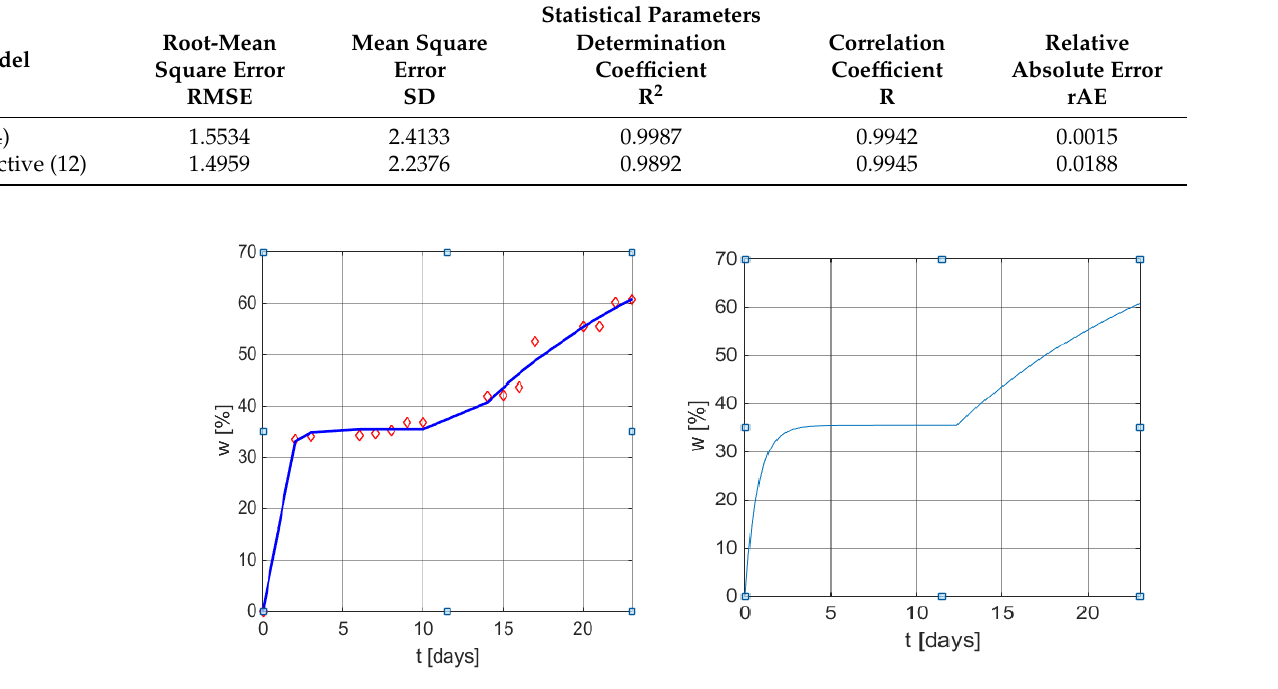
Table 3. Results obtained using the experimental data presented previously [32].